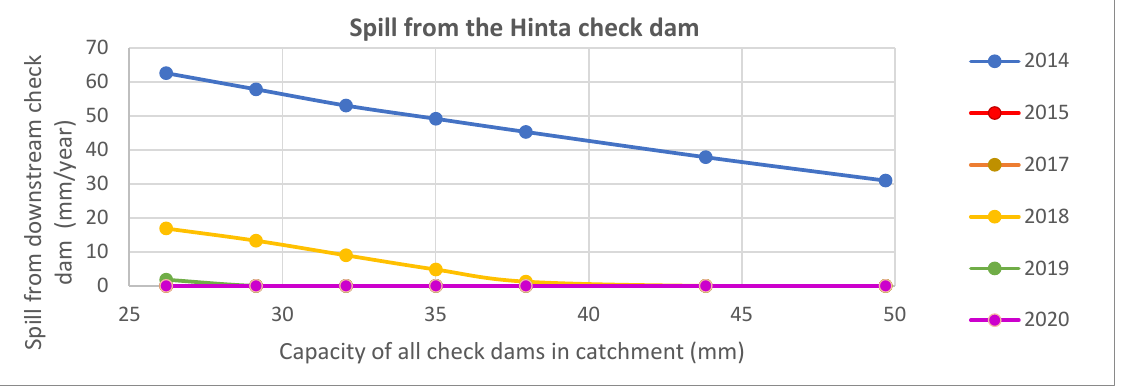
Figure 7. Predicted impact of the hypothetical upstream check-dam development in the Hinta catchment: ( a ) recharge from the downstream check dam; ( b ) total recharge from all check dams; and ( c ) spill from the downstream check dam. Note that the 2016 estimated spill of 222 mm (reducing to 194 mm) far exceeds other years and is excluded from ( c ). (No spill in 2015, 2017, 2019 or 2020.)